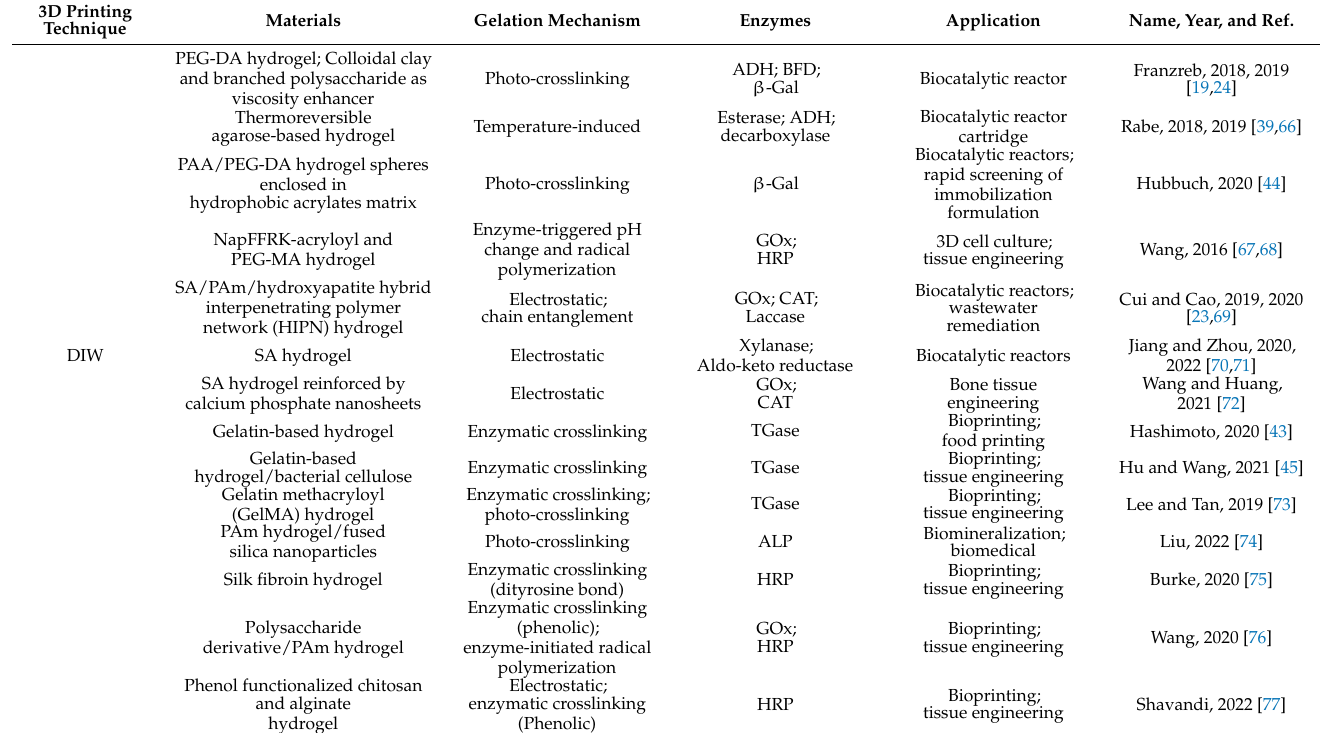
Table 3. Physical entrapment strategies for enzyme immobilization during 3D